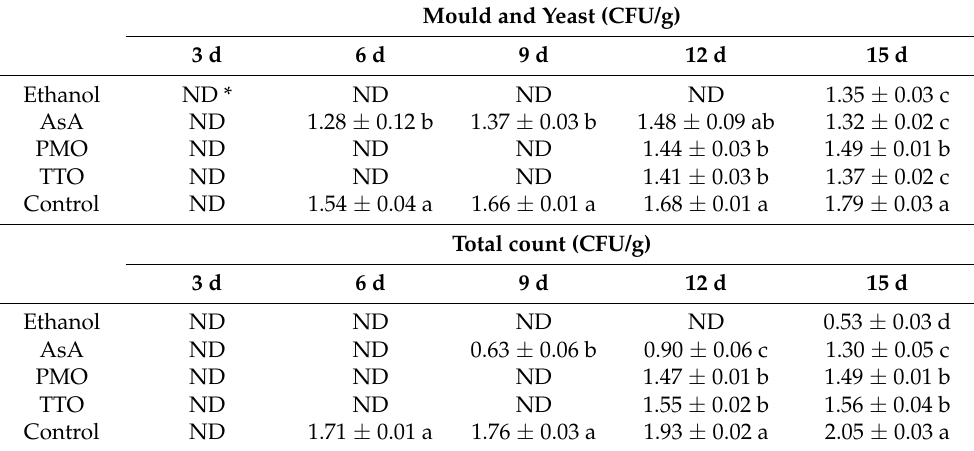
Table 2. Effect of ethanol, ascorbic acid (AsA), peppermint oil (PMO), and tea tree oil (TTO) on mould and yeast and total count (log CFU/g) of fresh-cut green bean pods stored at 5 ◦ C for 15 d. Data are mean of three replicates ± standard errors. Different letters indicate significant differences (Tukey test, p <